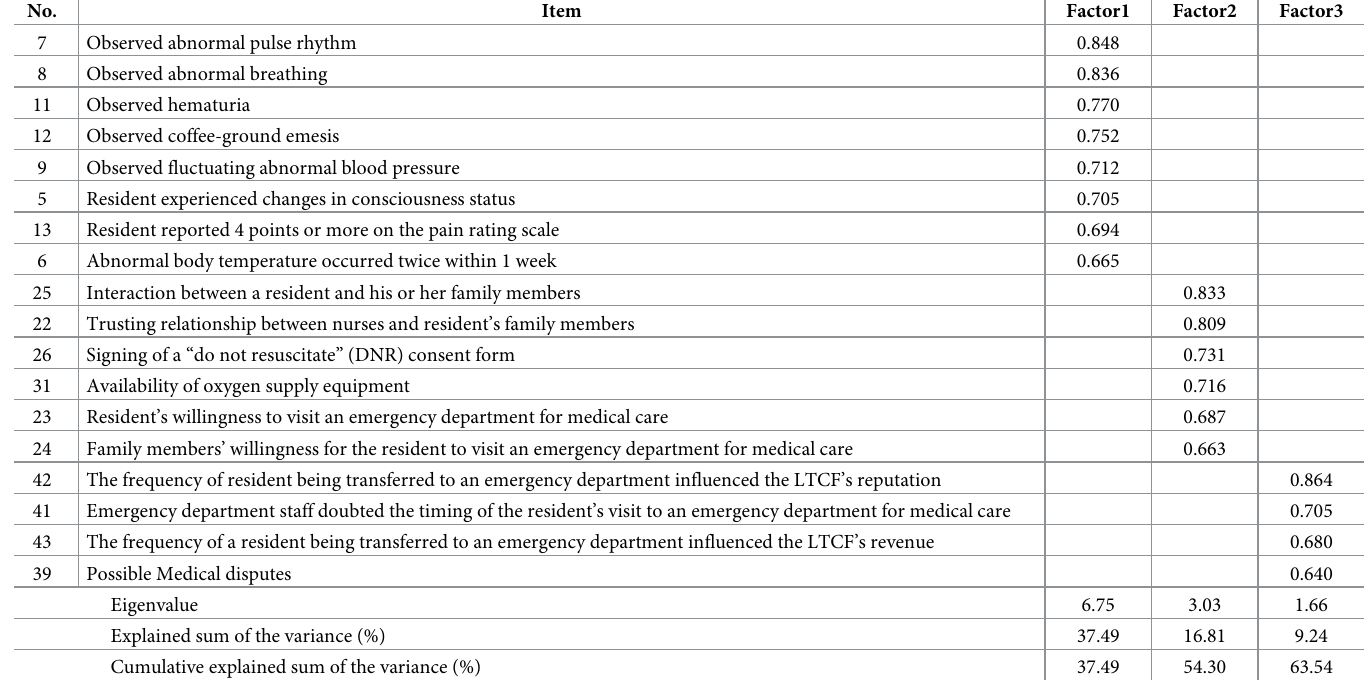
Table 2. Results of maximum likelihood ( N =